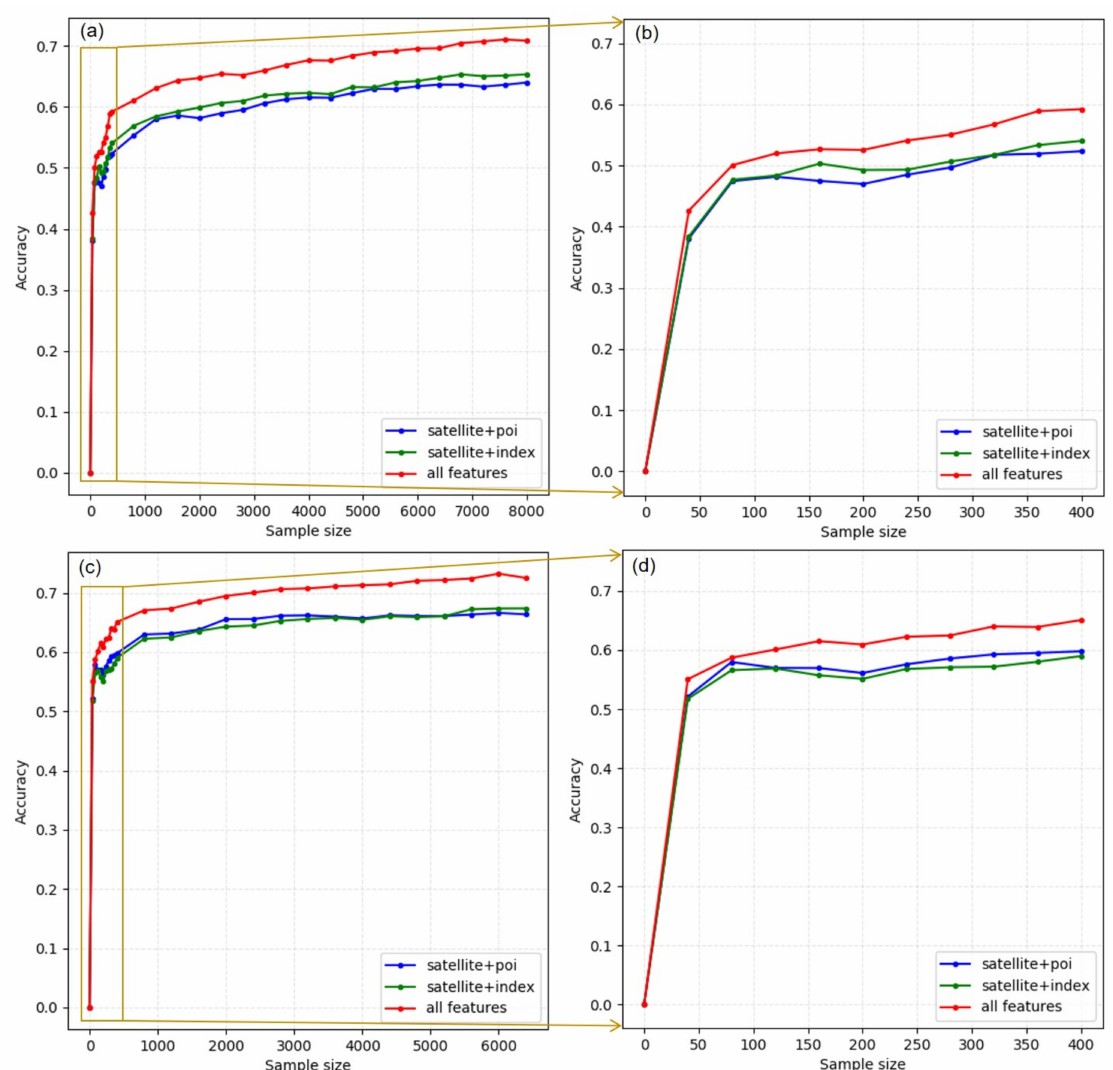
Figure 19. Accuracy for different training sample size (run 1000 times each): ( a ) training samples balanced; ( b ) from 0 to 400 samples of graph ( a ); ( c ) training samples proportionally; and ( d ) from 0 to 400 samples of graph ( c ).